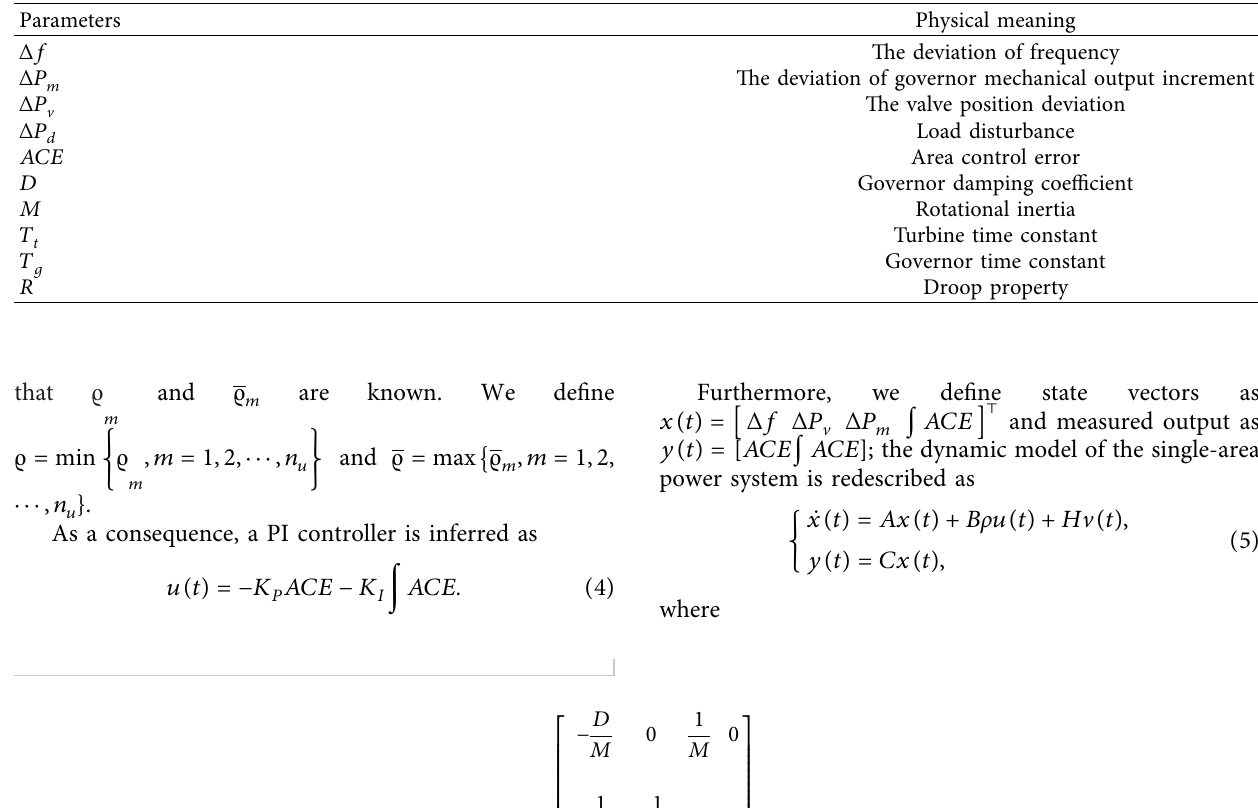
Table 1: Te physical meaning of